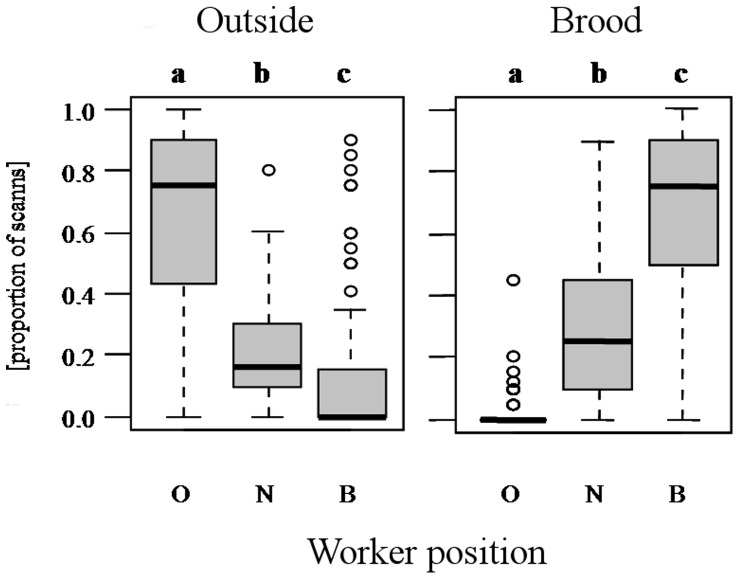
Spatial flexibility of M. rubra workers.The graph presents the proportion of scans where an individual was detected at one of the three monitored positions of subnests containing spatial specialists of one type only. We recorded workers present on the outside of the nest (O), within the nest but not at the brood (N) and workers at the brood (B). During this experiment we never detected workers directly in the entrance and consequently decided to monitor workers near the entrance but inside the nest (N). Workers were found more often at the position they were originally located in even after the alteration of colony task demand. Presented are medians and quartiles circles indicate outliers. Significant differences between the positions are indicated by different lower case letters on top of the figure (all p<0.0001).